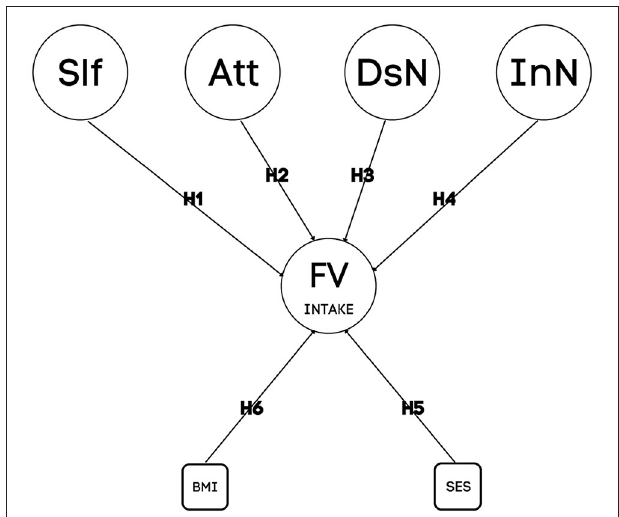
FIGURE 1 | Proposed prediction model with hypotheses for weekly frequency of Fruit and Vegetable Intake regarding social psychological determinants, Socioeconomic Status (SES), and Body Mass index (BMI). H1–H6, Hypothesis 1–6; Sl, Self-efficacy; Att, Attitudes; DsN, Descriptive social norms; InN, Injunctive social